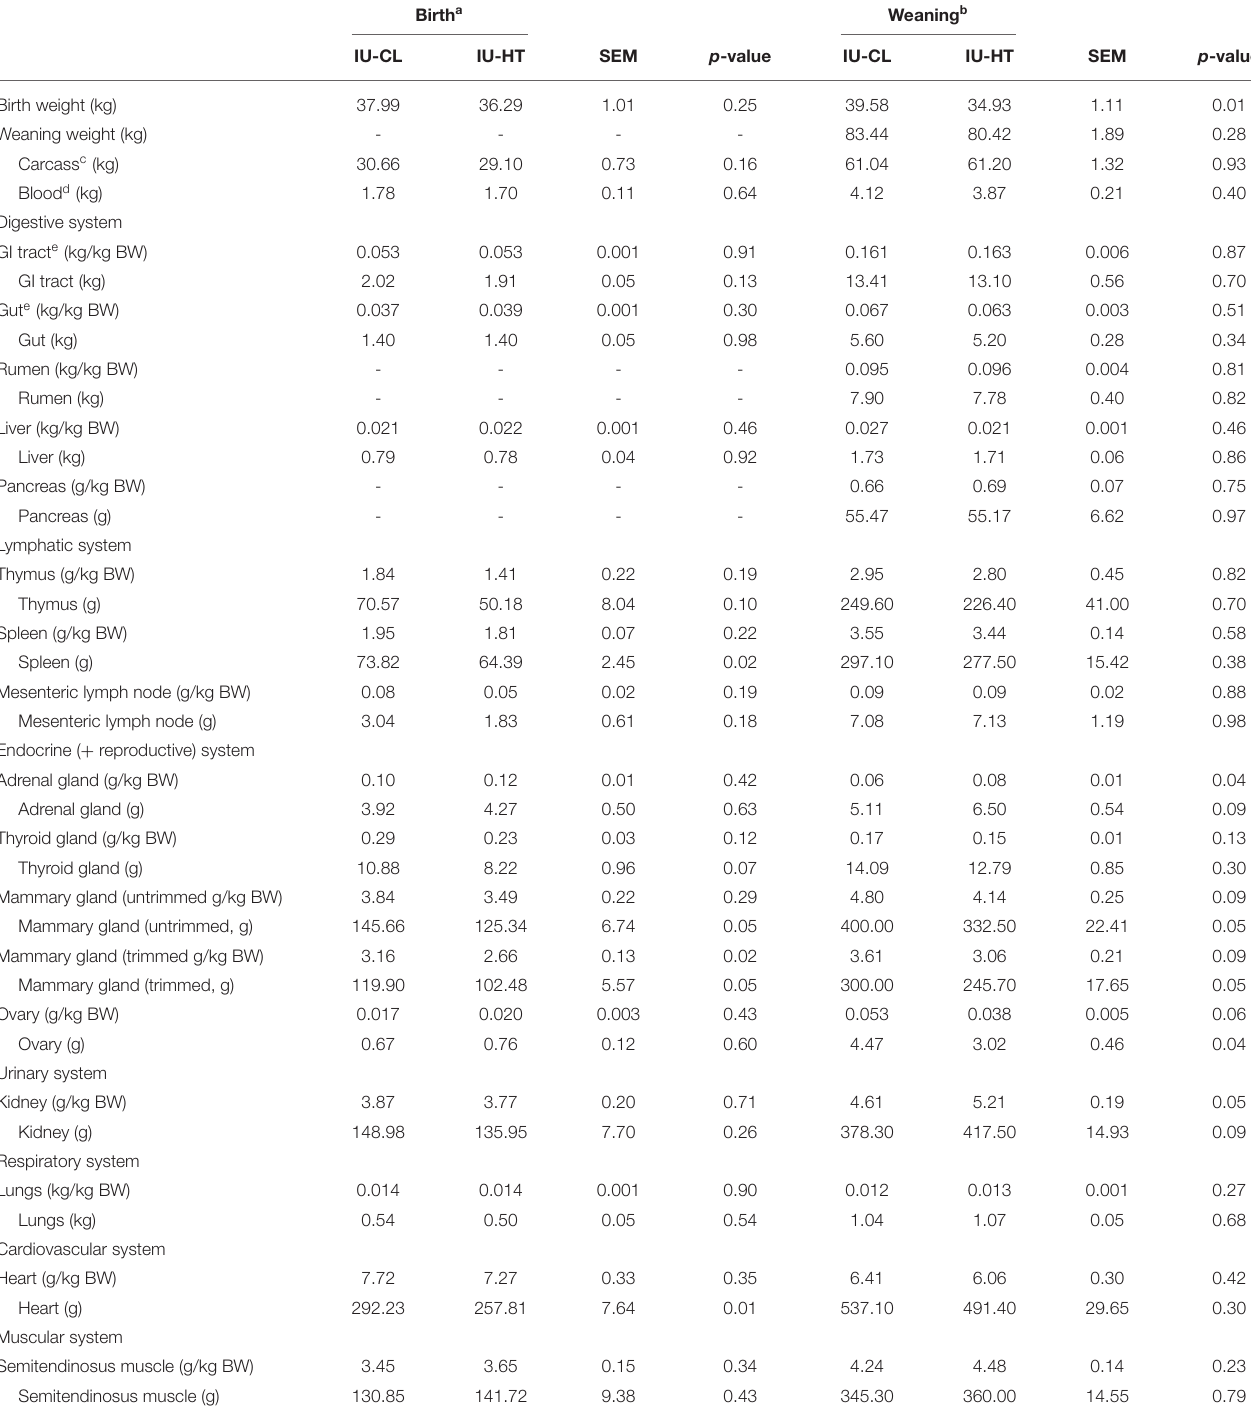
TABLE 1 | Organ weights of heifers exposed to late gestation in utero heat stress (IU-HT) or cooling (IU-CL), assessed at either birth or after